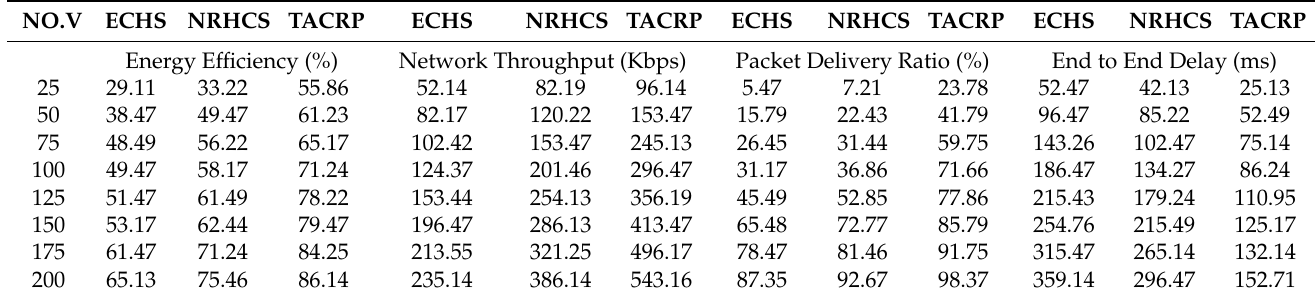
Table 3. Overall Performance Value Analysis-According to number of vehicles.